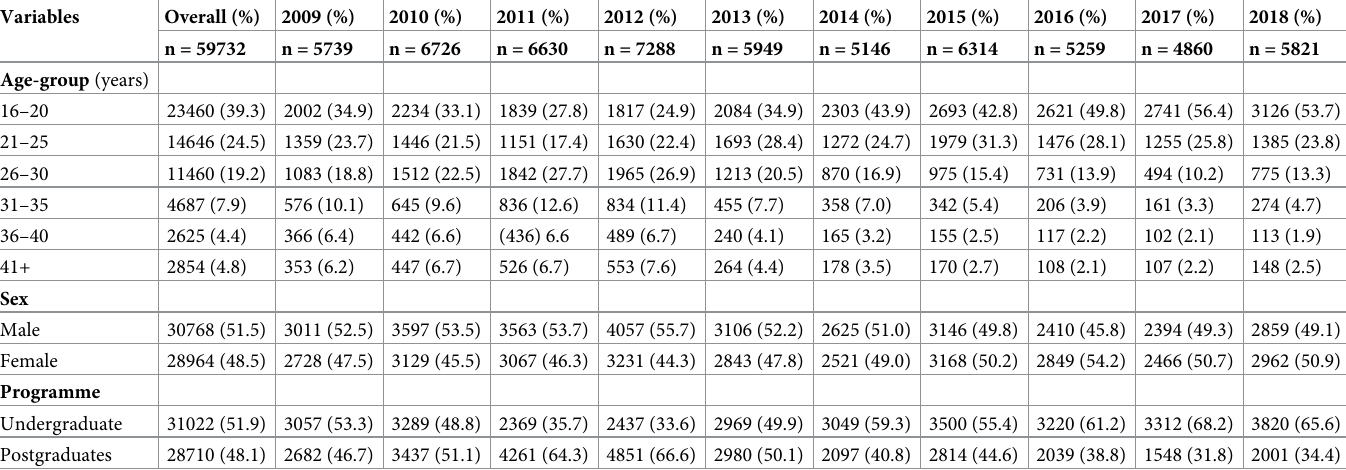
Table 1. Socio-demographic characteristics of students in each year of entry at the University of Ibadan from 2009–2018. Variables